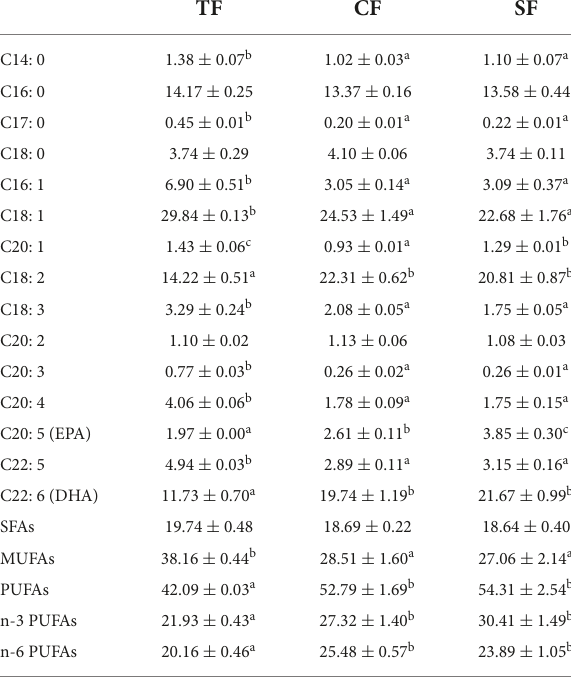
TABLE 8 Flesh fatty acid composition of largemouth bass fed trash fish and formula feeds (percentage of fatty acids,%). 1